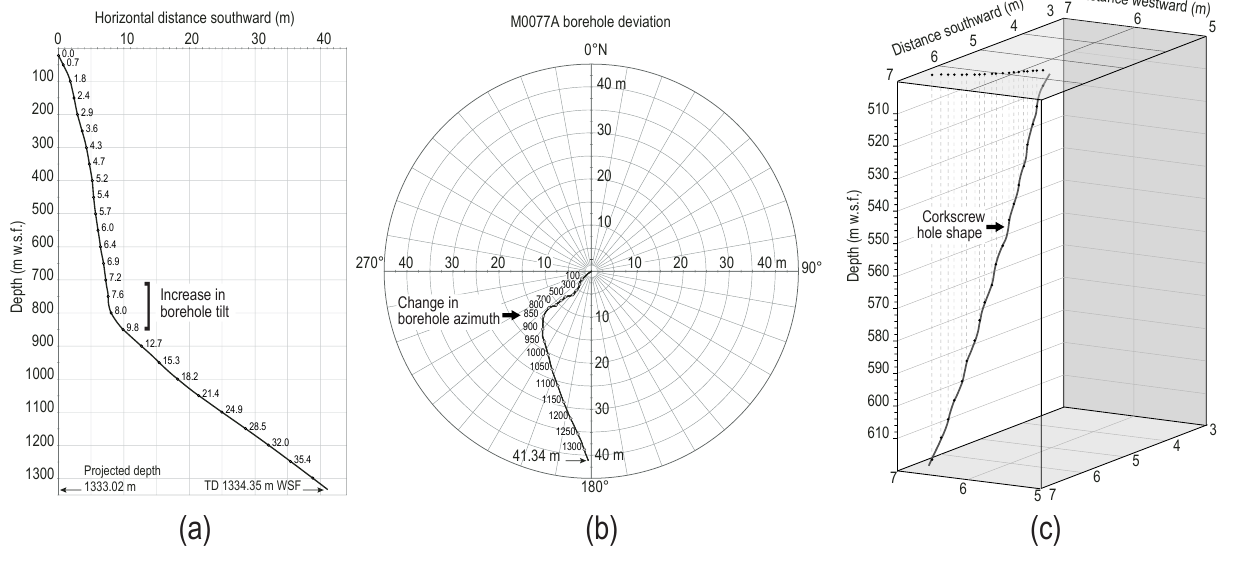
Figure 2. (a) true vertical depth and southward deviation of Hole M0077A. Note the increase in borehole tilt between 750 and 850mw.s.f. (b) top view projection of the borehole path (modified from Gulick et al., 2017). Note the change in hole direction from southwest to southeast between 800 and 950mw.s.f. (c) zoom on the 500–610mw.s.f. interval in post-impact carbonates illustrating a corkscrew borehole shape. mw.s.f. is meter wireline depth below